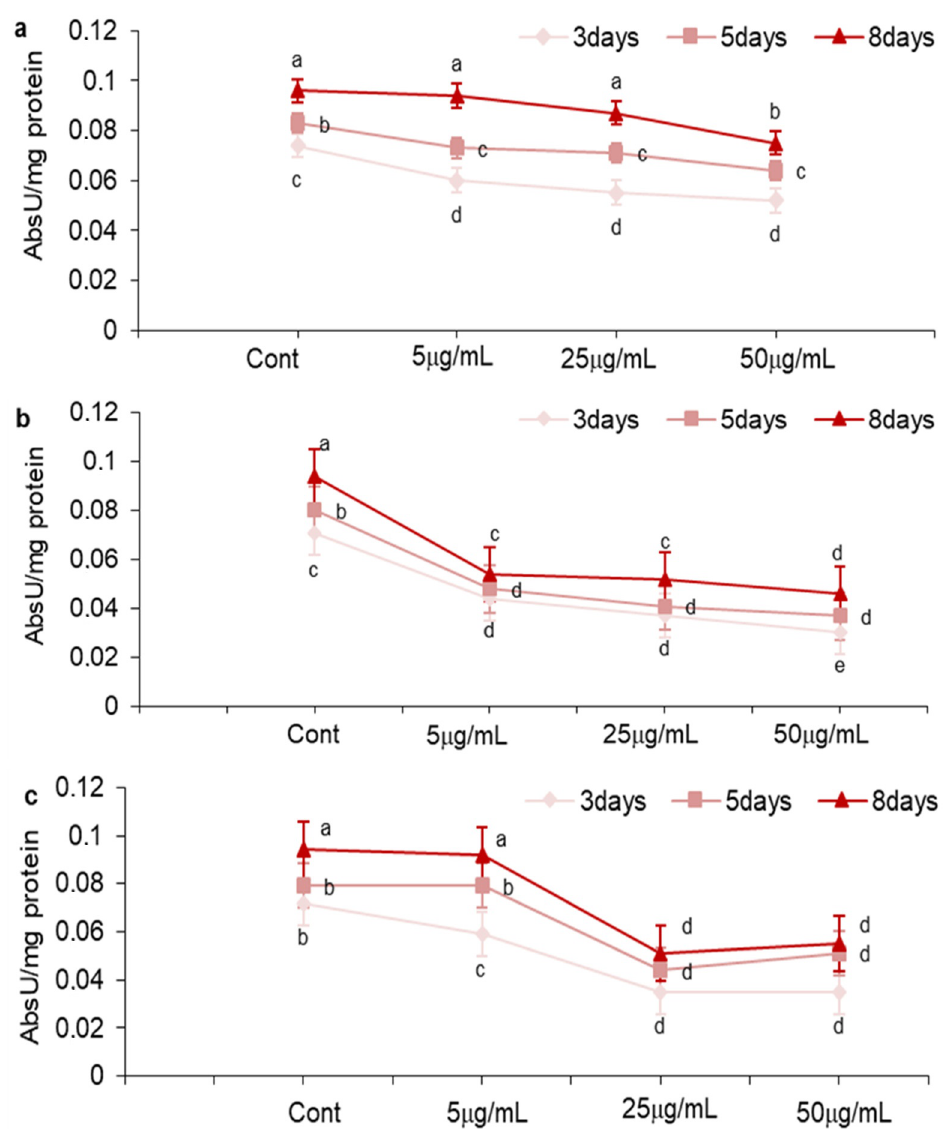
Figure 3. Effect of mosloflavone (MOS) ( a ); negletein (NEG) ( b ); 5,6-dihydroxy-flavone (DHF) ( c ), on lipoxygenase (LOX) activity in A. carbonarius cultured in CDY 0.5% medium. Means marked by the same letter are not significantly different (Fisher’s Protected LSD Test, p ≤ 0.05 ). Cont = untreated cultures; AbsU = absorbance units.